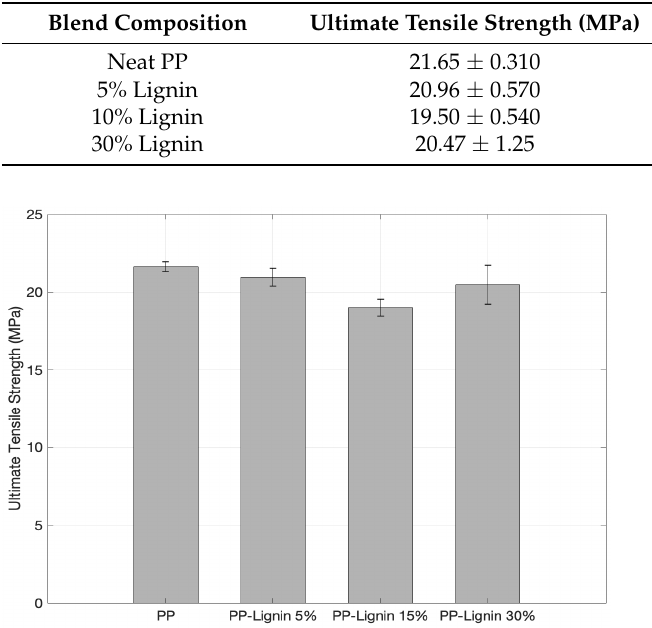
Figure 9. Ultimate tensile strength comparison (UTS). Table 5. Comparison of Ultimate Tensile Strength of PP-lignin with literature.